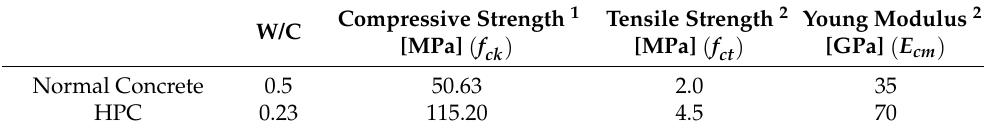
Table 2. Mechanical properties of normal concrete and